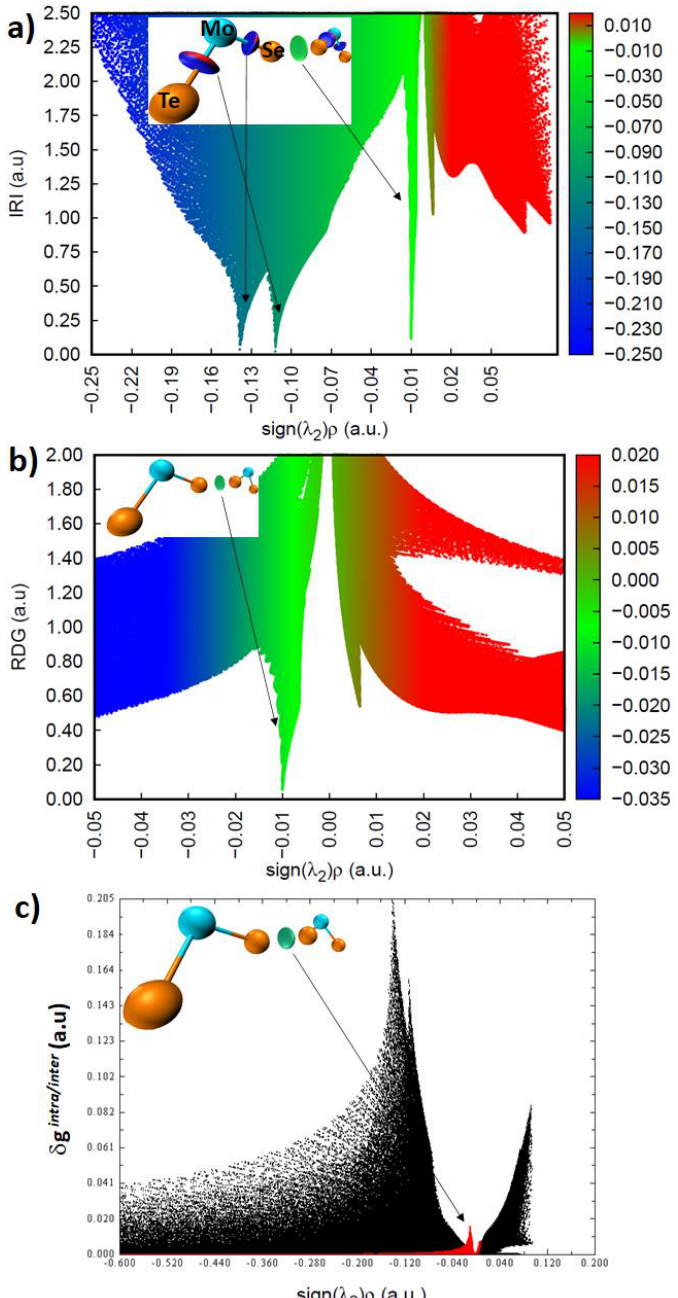
Figure 4. MP2(Full)/def2-TZVPPD computed ( a ) sign( λ 2 ) × ρ vs. IRI, ( b ) sign( λ 2 ) × ρ vs. RDG, and ( c ) sign( λ 2 ) × ρ vs. IGM-based δ g intra/intra plots for the (TeMoSe) ··· (TeMoSe) dimer. The inset in each plot represents the ball-and-stick model of the dimer with an isosurface in the intermolecular region between the bonded atomic basins. The isosurfaces correspond to isovalues of 1.1, 0.4 and 0.008 a.u. with IRI, RDG and IGM-based approaches, respectively.